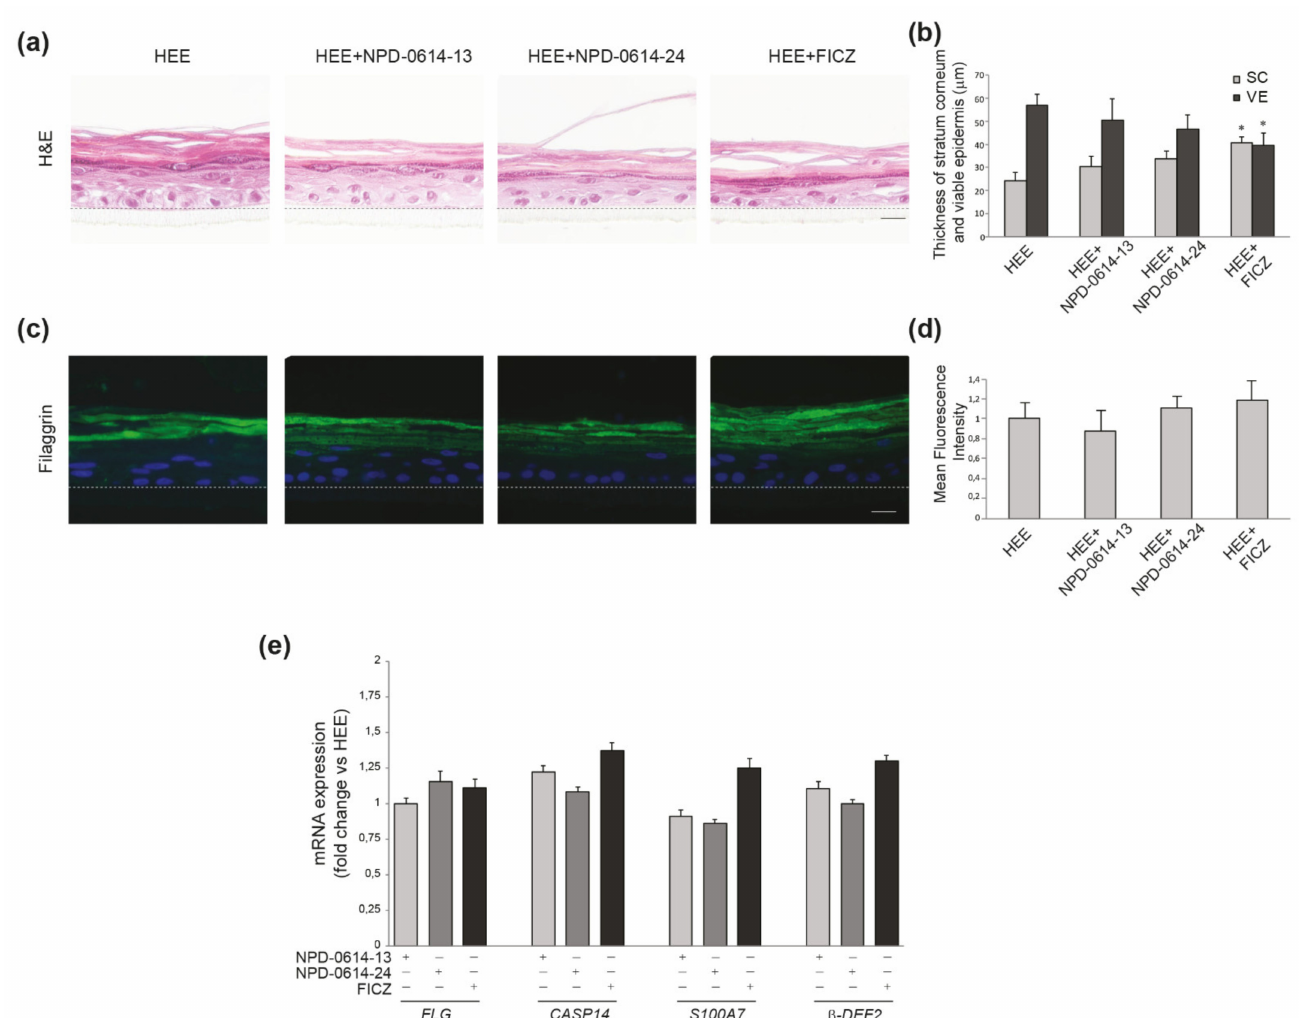
Figure 6. NPD-0614-13 and NPD-0614-24 safety profile on human epidermal equivalents (HEEs). ( a ) Hematoxilin–eosin staining of HEEs cultured in presence or absence of NPD-0614-13, NPD-0614-24 (25 µ M) and FICZ (100 nM) for 72 h. Bar: 50 µ m. ( b ) Morphometric analysis of the stratum corneum (SC) and the viable epidermal layers (VE). The thickness of SC and VE was expressed as mean value ± SD (* p < 0.05 vs. untreated HEEs). ( c ) Representative immunofluorescence images after using filaggrin antibody. Nuclei were counterstained with DAPI. Bar: 20 µ m. ( d ) Quantitative analysis of fluorescence intensity was expressed as mean value ± SD. Dashed black/white lines represent the junction between the basal layer and the membrane of the insert. ( e ) Quantitative real time PCR analysis of filaggrin, caspase-14, S100A7 and beta-defensin-2 in HEEs, in the presence of absence of NPD-0614-13, NPD-0614-24 (25 µ M) and FICZ (100 nM) for 72 h. All mRNA values were normalized against the expression of GAPDH and were expressed relative to untreated